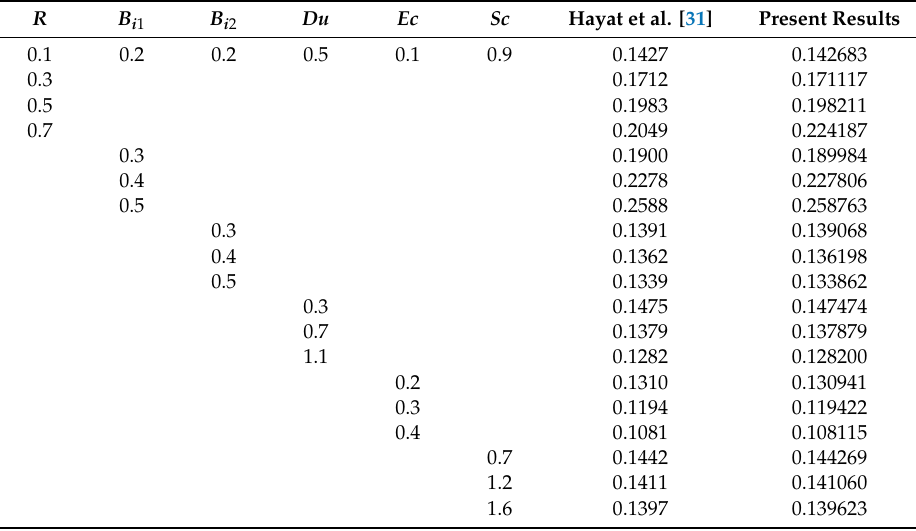
Table 2. Variation in the local Sherwood number Sh x / Re 1/2 x for various